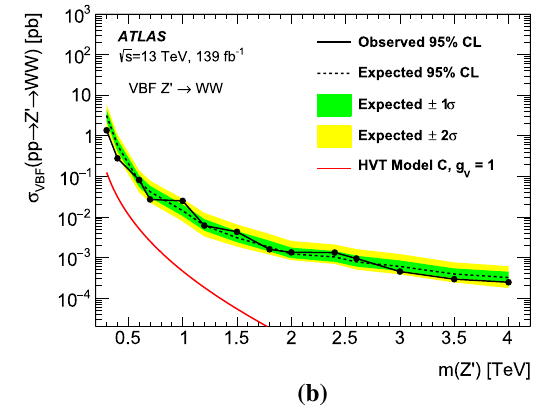
Fig. 14 Observed (black solid curve) and expected (black dashed the expected limits. Limits are calculated in the asymptotic approxima- tion below 3 (1) TeV and are obtained from pseudo-experiments above curve) 95% CL upper limits on the a DY and b VBF production cross- √ s = 13 TeV in the WW decay mode as that for DY (VBF) production. Theoretical predictions as functions of section of an HVT Z (cid:4) boson at the Z (cid:4) boson mass are overlaid in a for Model A (red solid curve) and functions of its mass from the search in the 1-lepton channel. The green (inner) and yellow (outer) bands represent ± 1 σ and ± 2 σ uncertainty in Model B (red dotted curve) and in b for Model C (red solid curve)